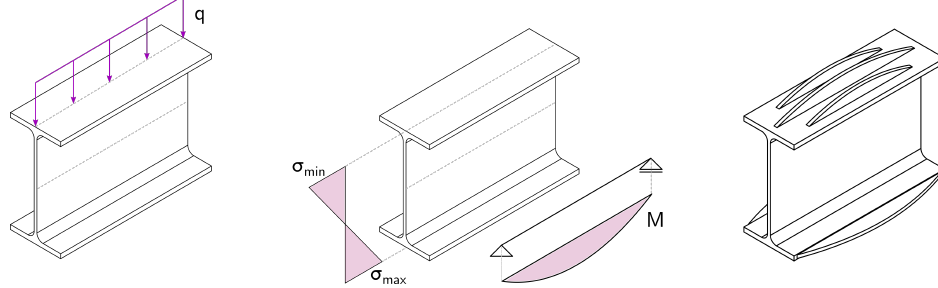
Figure 11. Design of reinforcements of flanges, that is, load cases